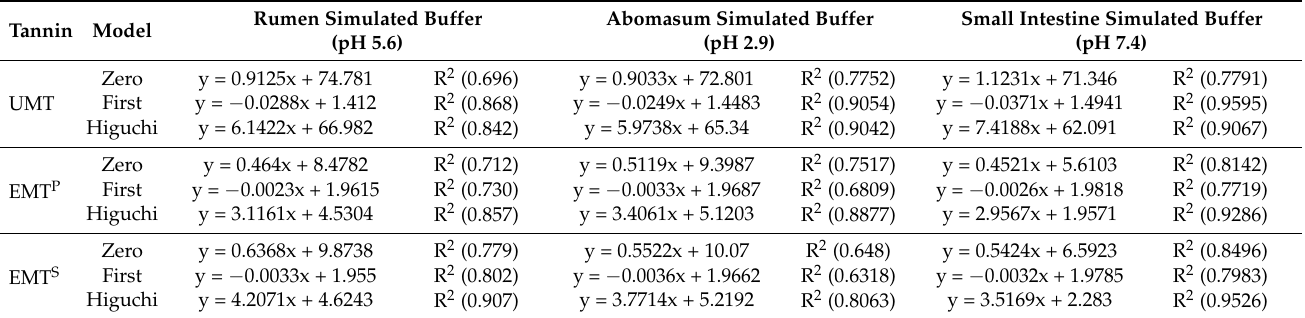
Table 2. Release rate kinetics of unencapsulated mimosa tannin or encapsulated mimosa in palm and sunflower oils in GIT simulated media.